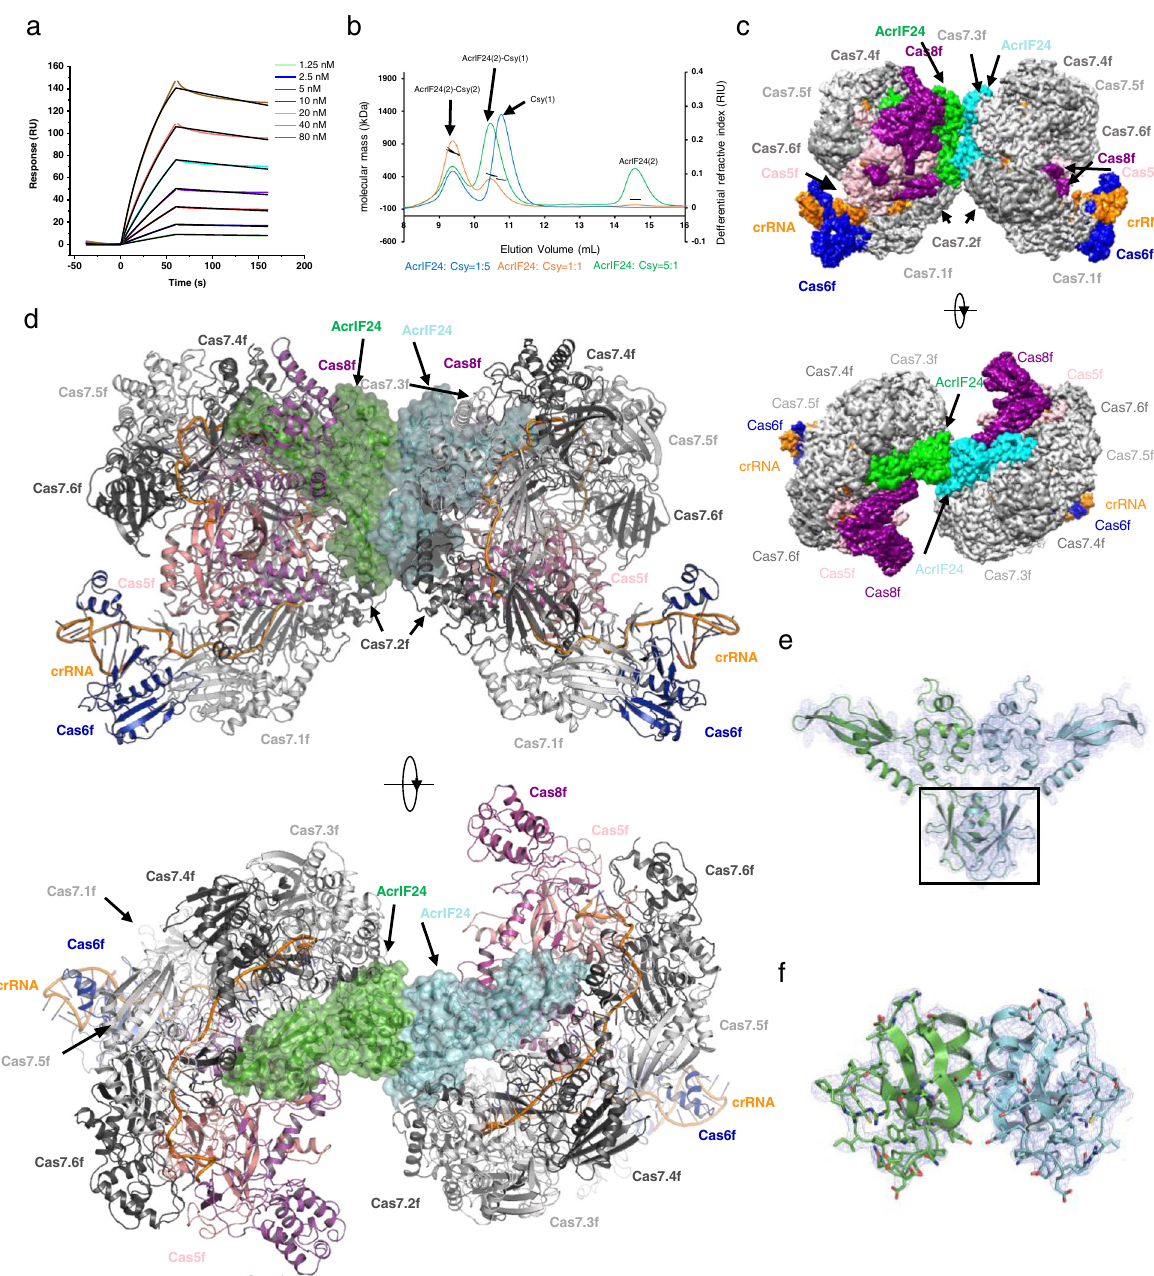
Fig. 3 Cryo-EM structure of the Csy-AcrIF24 complex. a Binding kinetics of AcrIF24 with the Csy complex, measured by surface plasmon resonance (SPR) method. SPR curves (colored curves) were fi t kinetically using a 1:1 Langmuir binding model (black lines). The data shown are representative of three independent experiments. b Static light scattering (SLS) studies of the mix of AcrIF24 and the Csy complex under different molar ratios. The predicted composition of each peak based on the calculated molecular weight is shown above the peaks. The calculated molecular weights of the peaks are shown in Supplementary Table 2. c Cryo-EM map of the Csy-AcrIF24 complex with each subunit color-coded. Two views are shown. d Atomic structure of Csy- AcrIF24 in cartoon representation with each subunit colored as in c . Two views are shown. e The AcrIF24 dimer in the Csy-AcrIF24 structure. Cryo-EM density is shown in a slate mesh. The MD of AcrIF24 is marked in a box. f Close-up view of the MD of AcrIF24. Cryo-EM density is shown in slate